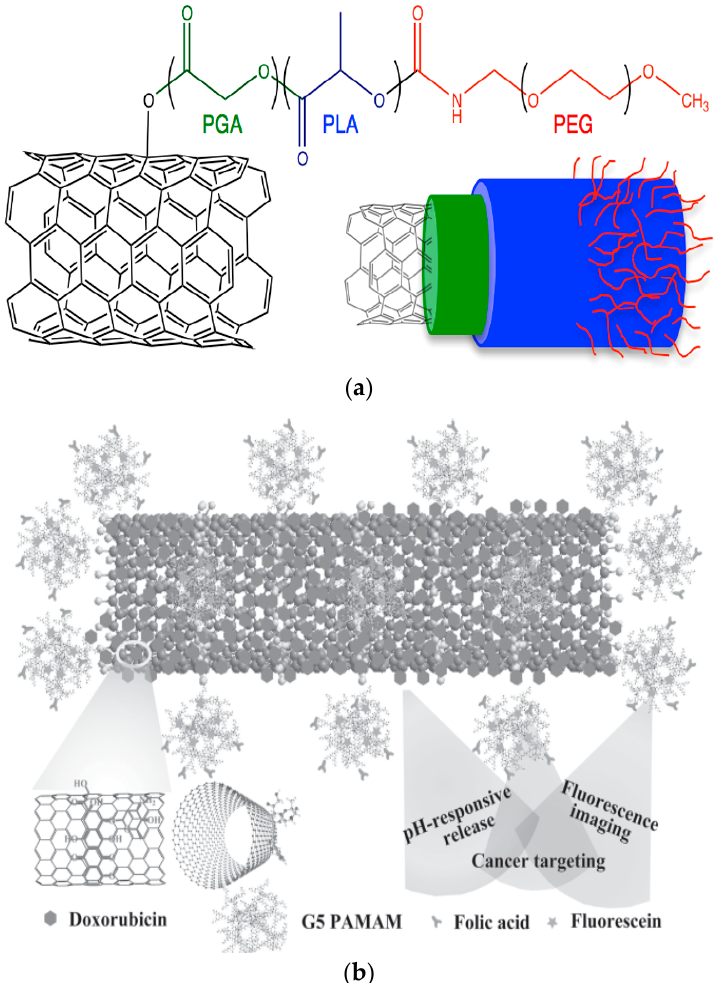
Figure 2. ( a ) Surface modification of carbon nanotubes (CNTs) with biocompatible PEGylated polymers [46]; ( b ) Schematic illustration of folate-targeted and fluorescently labeled multifunctional multiwalled carbon nanotubes (MWCNTs) for targeted and pH-responsive delivery of doxorubicin (DOX) to cancer cells [48].